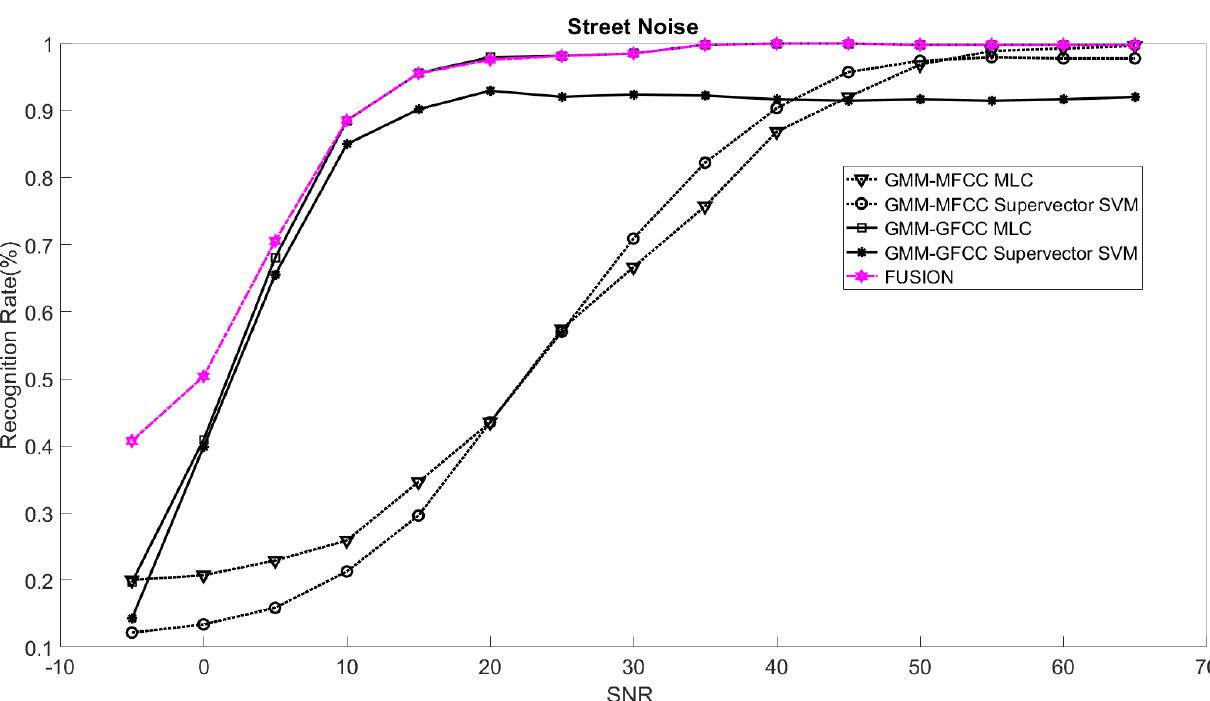
Figure 20. Rank-1 recognition rates of the fusion system and the base classifiers (two-stage) on utterances distorted with pink noise.